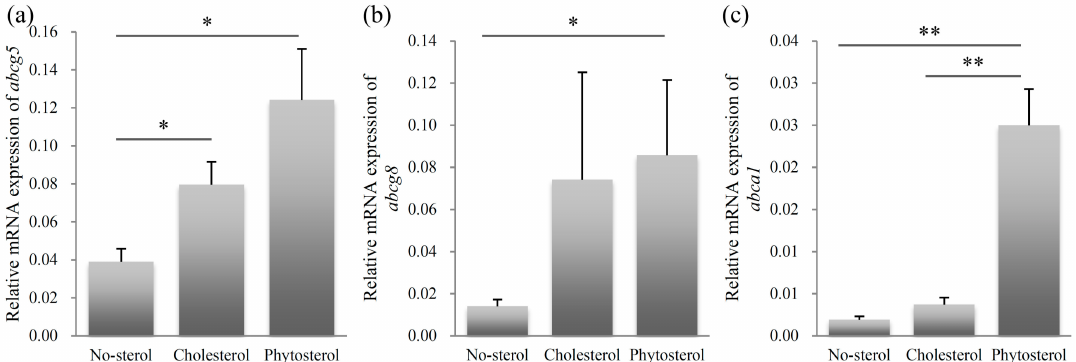
Figure 4. Relative mRNA expression of sterol excretion related genes abcg5 ( a ), abcg8 ( b ) , and abca1 ( c ). Left column: no-sterol group, Middle column: cholesterol-fed group, Right column: sitosterol-fed group. Data were expressed as mean ± SE ( n = 10, per group). Statistically significant difference is shown as * p < 0.05, ** p <